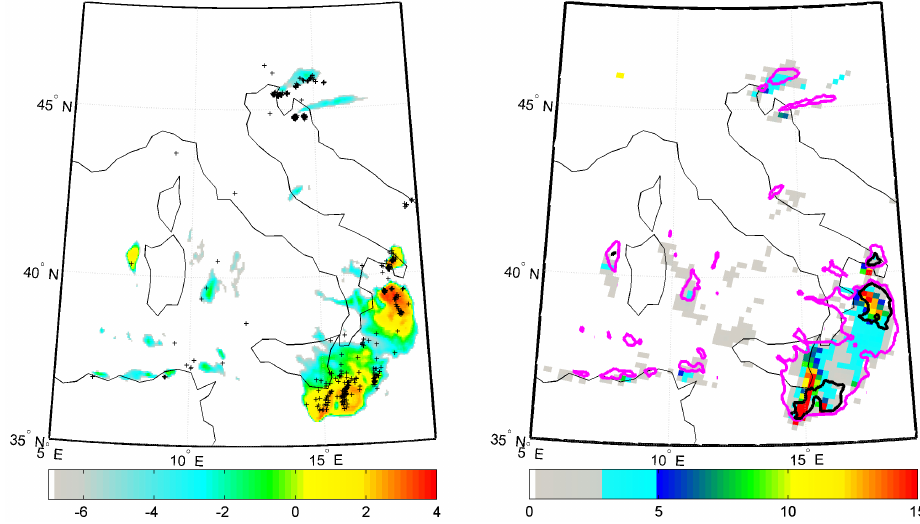
Fig. 1. Left panel: MSG SEVIRI water vapor – thermal infrared brightness temperature difference 1 T B (color scale in K) for the selected case study on 2 October 2009, 01:27UTC. Lightning flashes as observed from the ground-based LINET network over a 10-min period centered at the time of the SEVIRI observation are also shown as black crosses (+). Right panel: Instantaneous rainfall rates (color scale in mmh − 1 ) retrieved from AMSU overpass on 2 October 2009, 01:24UTC. As a reference, − 5.5K (pink line) and 1K (black line) 1 T B contours, as derived from the left panel, are also shown.